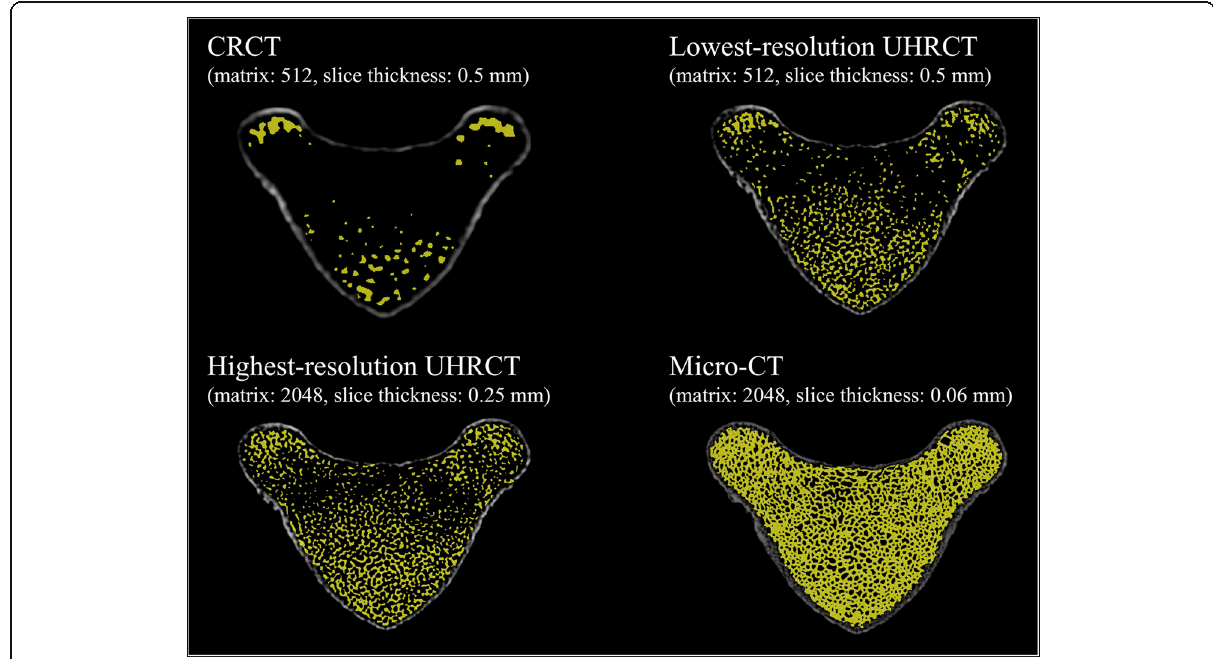
Fig. 4 Representative extracted images of the trabecular bone in tiger vertebrae on CRCT, lowest-resolution (matrix 512 × 512, slice thickness 0.5 mm) and highest-resolution (matrix 2048 × 2048, slice thickness 0.25 mm) UHRCT, and micro-CT. CRCT Conventional-resolution computed tomography, UHRCT Ultra-high-resolution computed